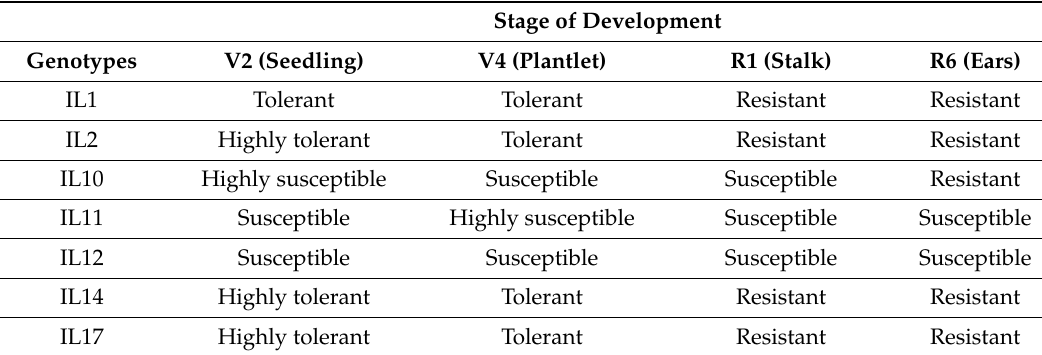
Table 1. Summary of the behavior of inbred lines at screening during the maize life